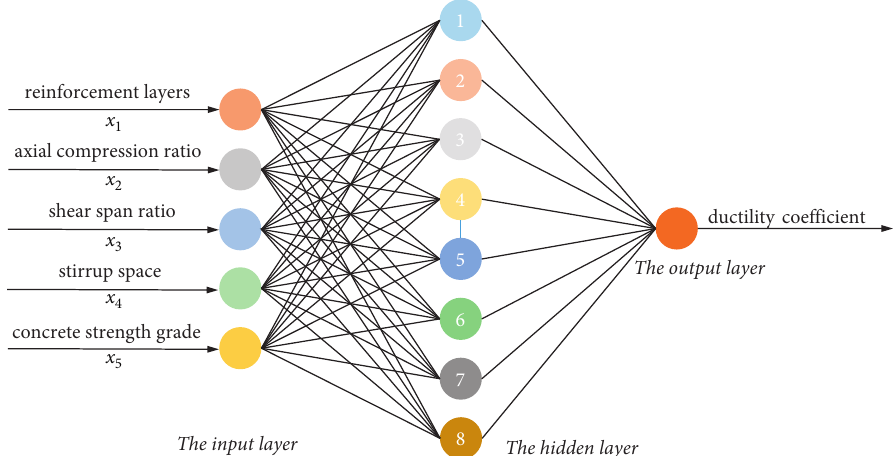
Figure 3: Architecture of three-layer backpropagation (BP) neural network